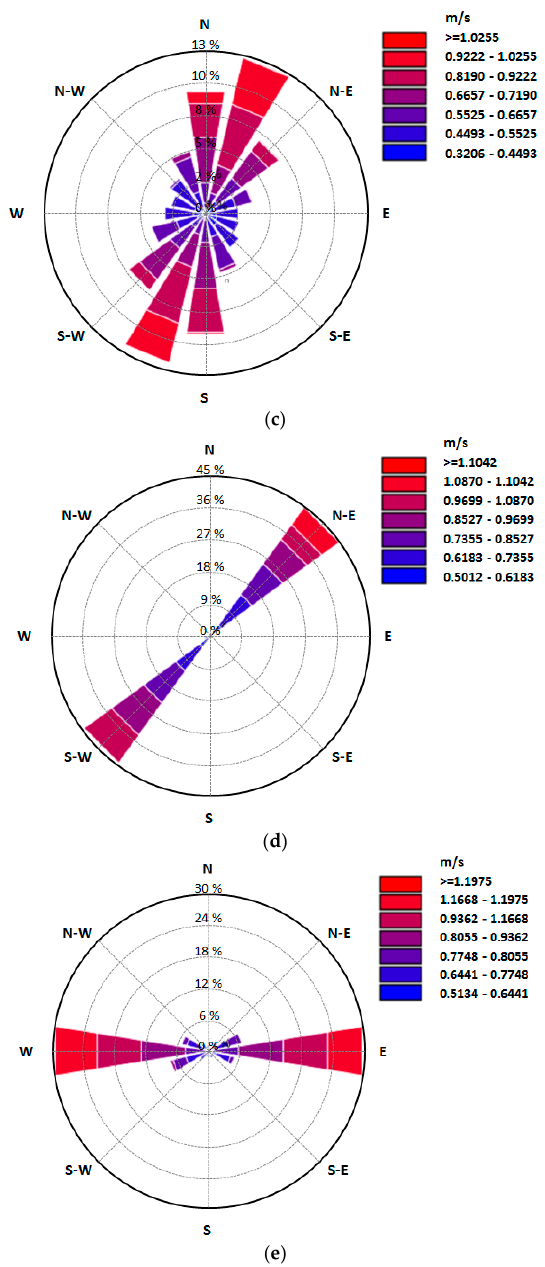
Figure 5. Marine current velocity rose diagrams. ( a ) Tanger; ( b ) Agadir; ( c ) El Hoceima; ( d ) Dakhla; ( e ) El Jadida.